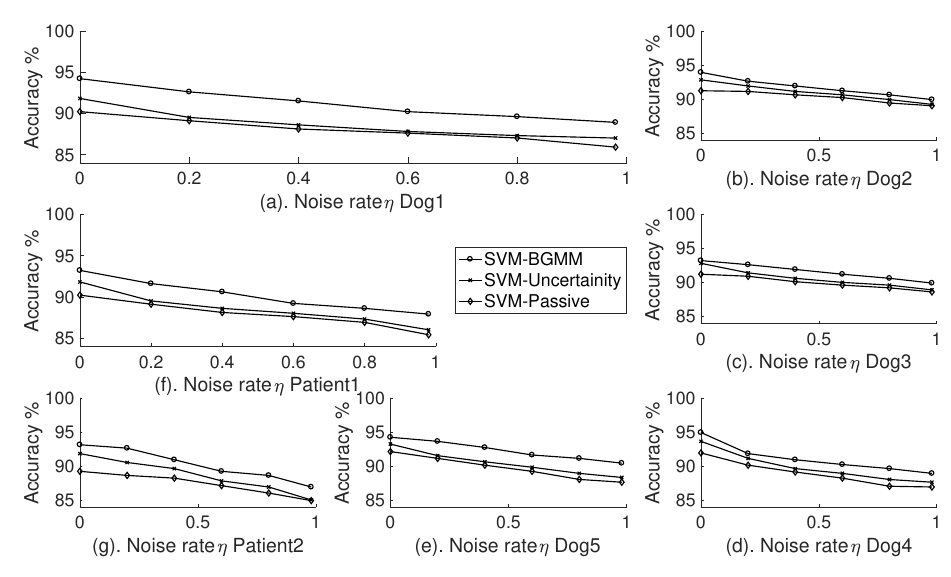
Figure 11. Noise complexity of three different settings of the the Support Vector Machine classifier. Accuracy as a function of noise rate ( η ) .